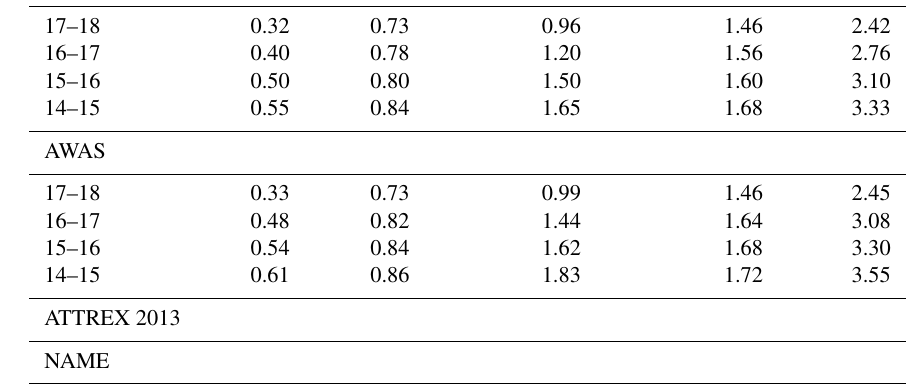
Table 5. Contribution from the very short-lived bromocarbons: CHBr 3 and CH 2 Br 2 to the bromine in the TTL, as given by modelled estimates and AWAS observations for ATTREX 2014 and 2013. [CHBr 3 ] and [CH 2 Br 2 ] means are shown. Altitude [km] [CHBr 3 ] [CH 2 Br 2 ] Br from CHBr 3 Br from CH 2 Br 2 Br-VSL org [ppt] [ppt] [ppt] [ppt] [ppt] ATTREX 2014 NAME 17–18 0.32